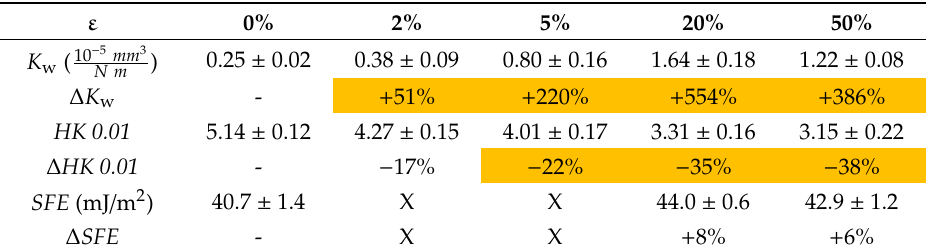
Table 7. Summary of test results of wear ( K w ), surface free energy ( SFE), and microhardness ( HK 0.01 ) for tensile deformed PE-HD.